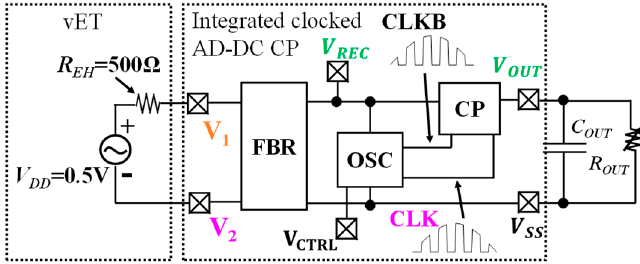
Figure 9. Measurement circuit.